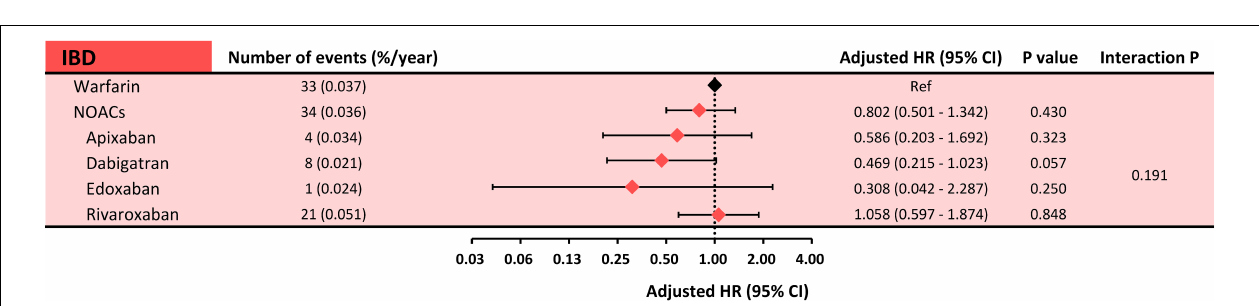
FIGURE 2 | Risk of clinical events of NOACs compared to warfarin. The risk of ischemic bowel disease was similar between the NOAC and warfarin groups. As for secondary endpoints, including ICH, major bleeding, ischemic stroke, mortality, myocardial infarction, and systemic embolism, NOACs were associated with a significantly lower risk compared to warfarin. HR, hazard ratio; CI, confidence interval; IBD, ischemic bowel disease; ICH, intracranial hemorrhage; MB, major bleeding; NOACs, non-vitamin K antagonist oral anticoagulants.